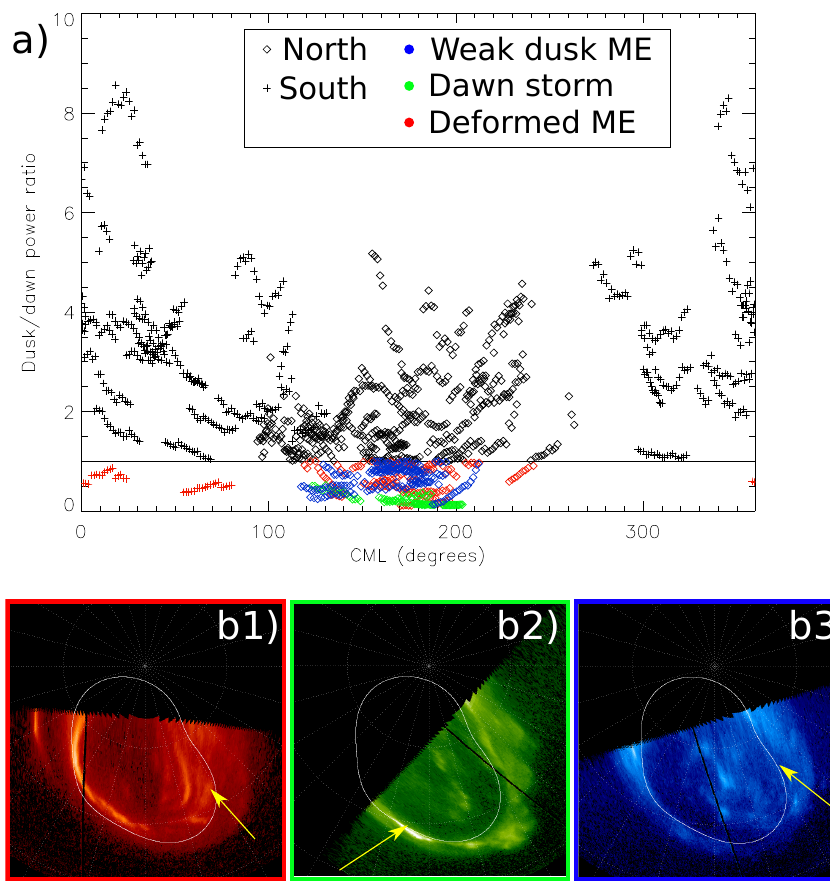
Figure 2. Panel (a) : plot of the ratio of the integrated emitted power in the 16:00 to 18:00LT sector (dusk side) over the 06:00 to 08:00LT sector (dawn side) for the northern (diamonds) and southern (pluses) hemispheres. Panels b1–b3 : polar projection of examples of the three classes of cases for which the dusk sector is weaker than the dawn sector. The first case is a case of strongly disturbed main emission, the second one is a dawn storm and the third case simply displays an unusually weak dusk arc. The arrow on the first image highlights the dawn arc while, on the last two images, the arrows highlight the expected location of the main